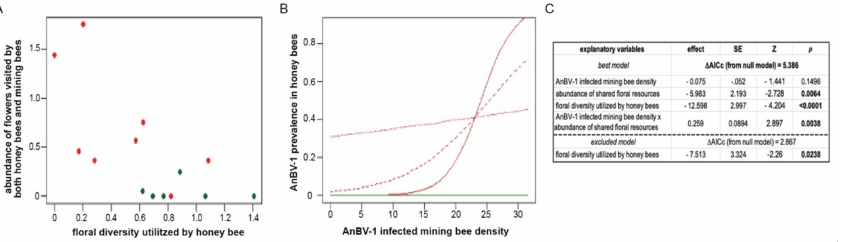
Figure 6. The probability of AnBV-1 infection in honey bees is greater in habitats with low floral diversity. ( A ). Patterns of bee resource use in high floral diversity sites (green) and low floral diversity sites (red), including the diversity of floral resources utilized by honey bees (horizontal axis) and the abundance of flower species that were shared between honey bees and mining bees (vertical axis); values scaled by 10,000 –1 floral units. ( B ). Best statistical model for the roles of AnBV-1-infected mining bees and floral diversity on the probability of AnBV-1 infection in honey bees. All models are logistic generalized linear mixed models (GLMMs) for the probability of AnBV-1 presence in honey bees, with 143 observations. Scheme 2. The best model was contrasted with a null model containing only the random effect of site. ( C ). Best model fit to data, describing the relationship between AnBV-1 prevalence in honey bees (vertical axis) and three habitat characteristics: (i) the density of AnBV-1-infected mining bees, (ii) the diversity of floral resources utilized by honey